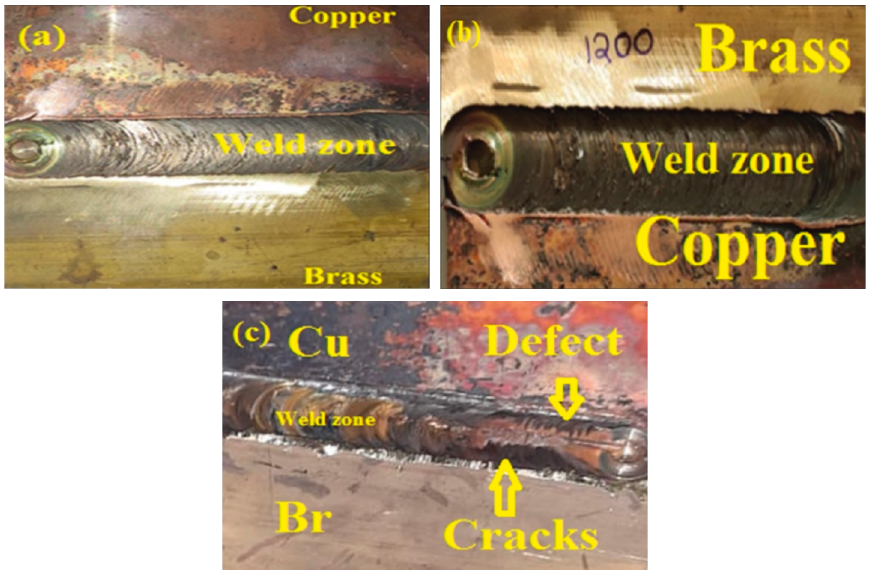
Figure 2: FSW samples after (a) 1000rpm, (b) 1200rpm, and (c) 1400rpm.